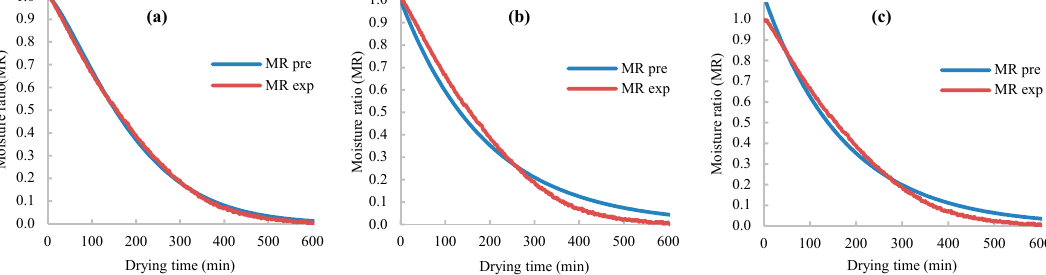
Figure 7. Comparison of experimental and calculated MR (45 °C, 0.20 m/s 6 mm): ( a ) ‐ Page model, ( b ) ‐ Newton (Lewis) model and ( c ) ‐ Henderson and Pabis model.